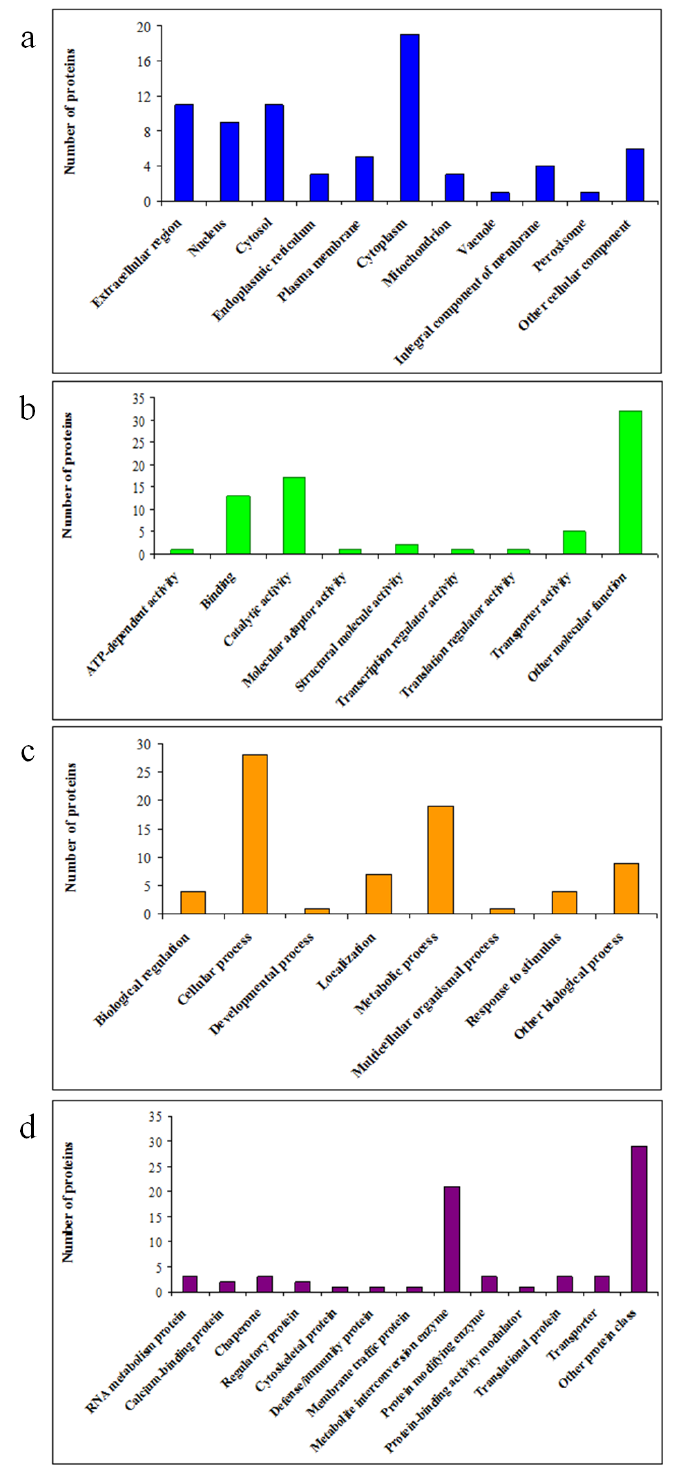
Figure 2. Functional categories and subcellular localization of DAPs from roots: subcellular localization ( a ), molecular function ( b ), biological process ( c ) and protein class ( d ).